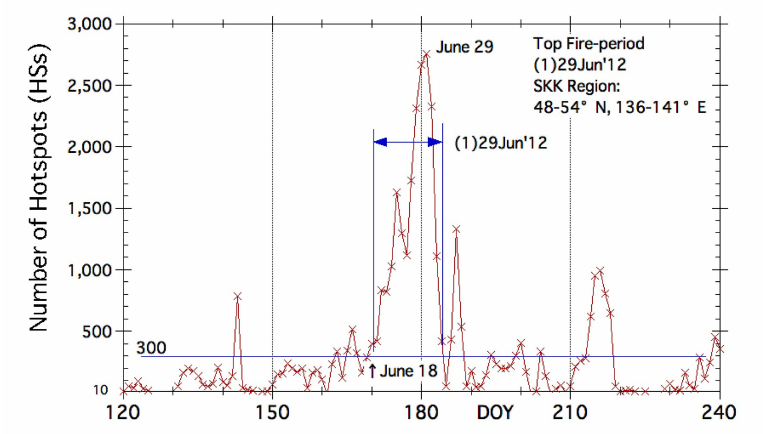
Figure 11. Fire activity in 2012 in the